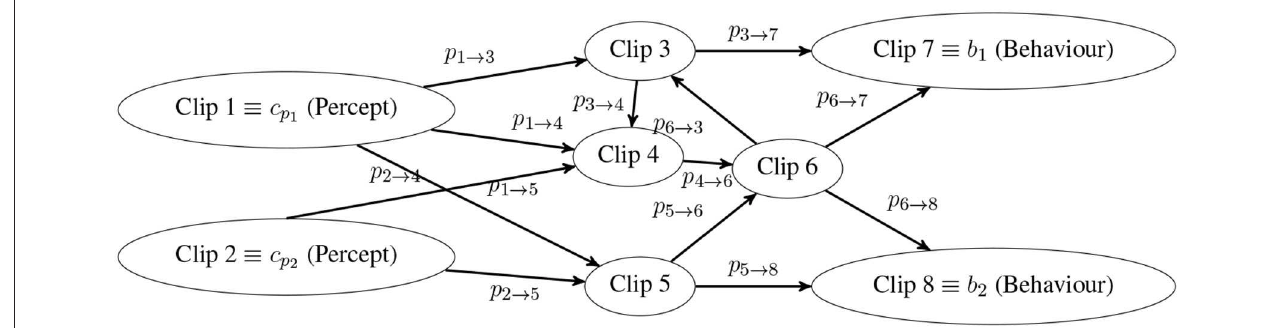
FIGURE 1 | Exemplary sketch of an episodic and compositional memory (ECM). A random walk always starts at a percept clip (e.g., clip 1, clip 2) and ends with a behavior clip (e.g., clip 7, clip 8). A transition c → c ′ from clip c to clip c ′ is done with the probability p c → c ′ . Intermediate clips (e.g., clip 3, clip 6) denote simulation of previous experiences, i.e., behaviors and percepts. The extensions made in this work enable the robot to create transitions between perceptual states on Layer D (i.e., active learning) and to add create new preparatory behaviors on Layer E.